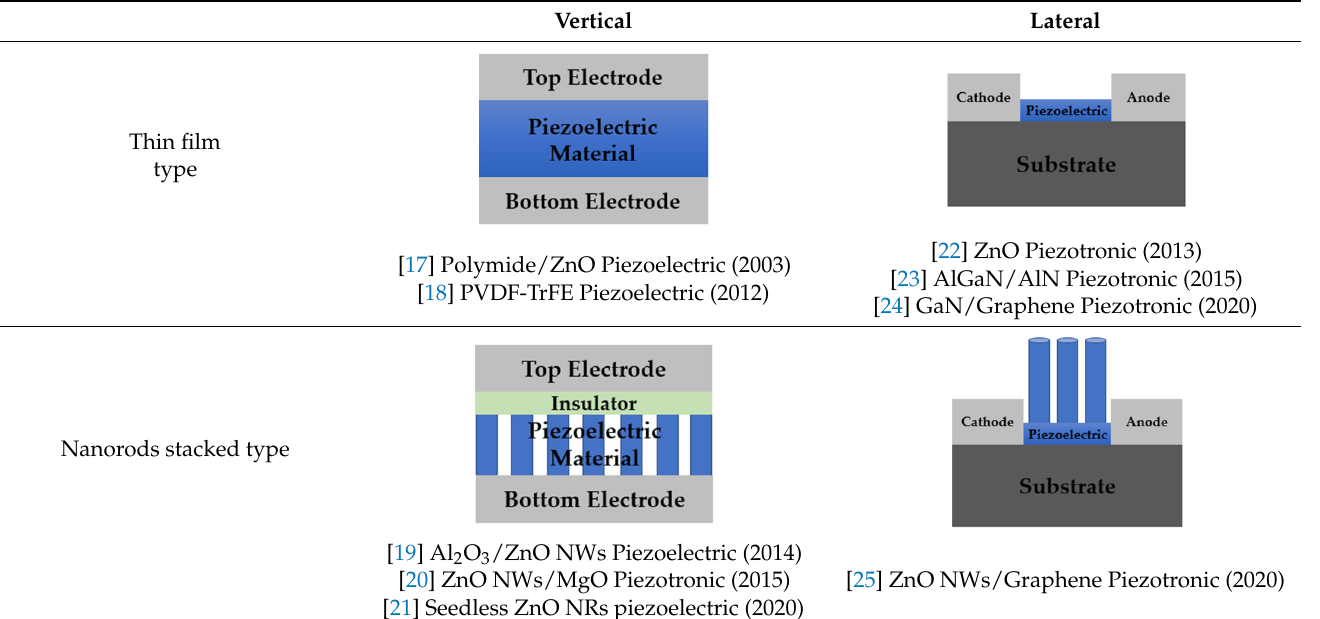
Table 1. Previously reported structure of MEMS presser sensor based on piezoelectric mechanism.